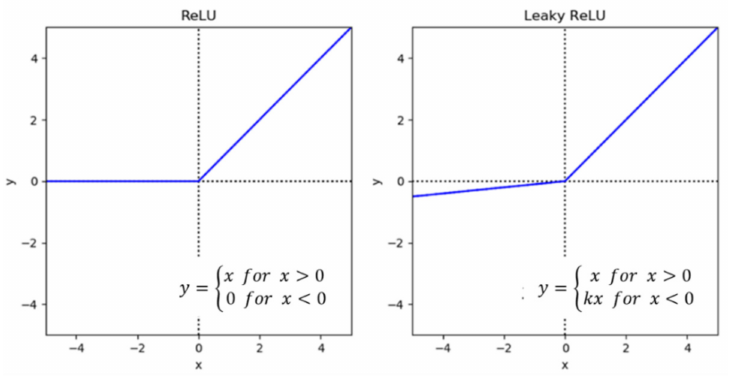
Figure 7. Graphs of the rectified linear unit (ReLU) and leaky ReLU (where x is the input value, y is the output value, and k is the small slope constant).